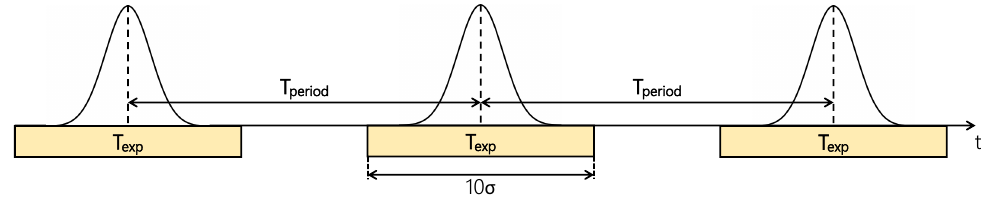
Figure 3. Quasiperiodic traffic of RTA STAs.